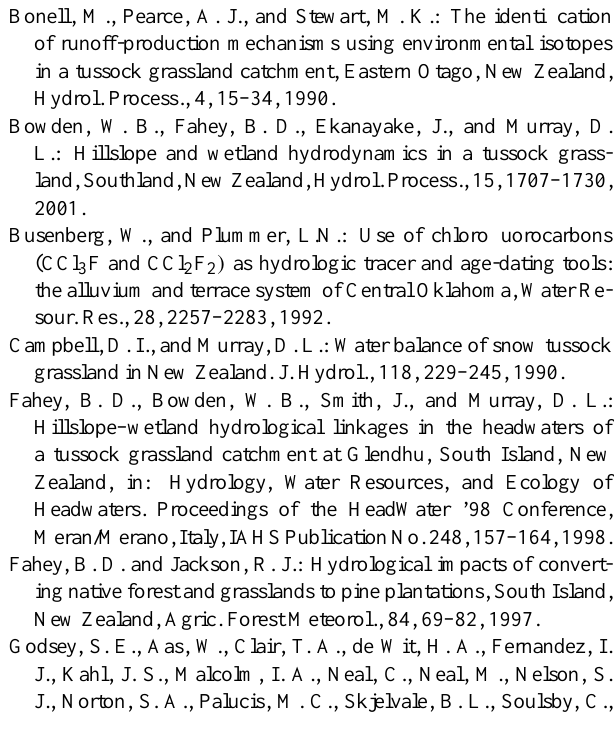
Fig. 7. Longitudinal and cross sections for catchment